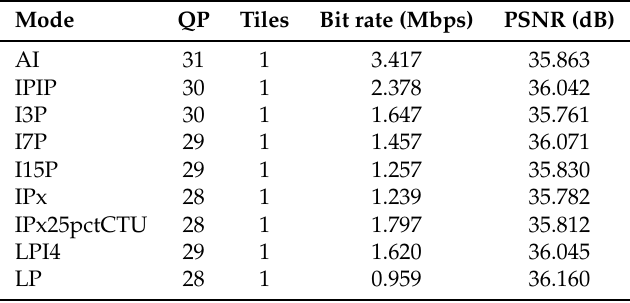
Table 5. QP values for achieving PSNR ≈ 36 dB (1 tiles per